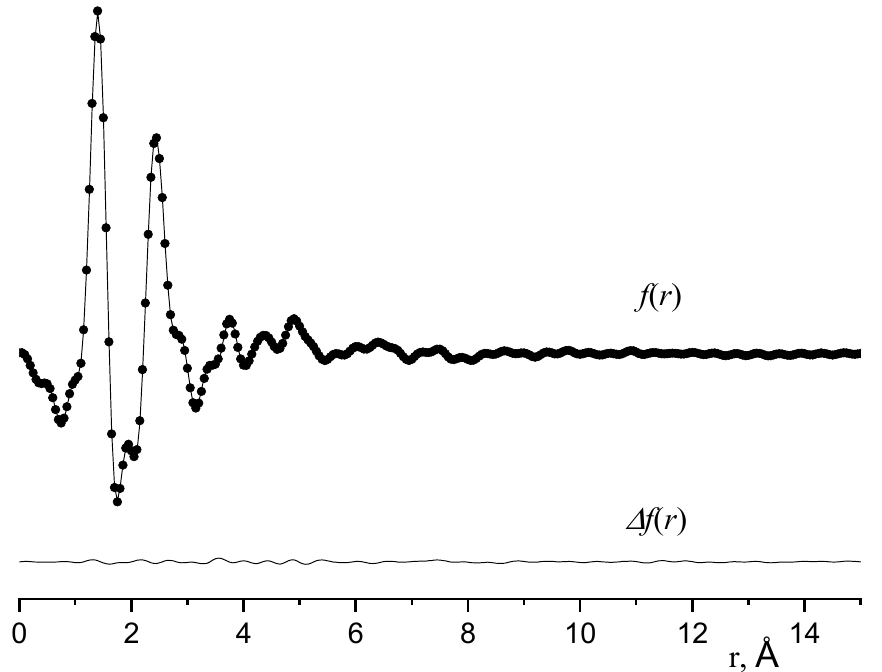
Figure 10. Experimental (dots) and theoretical (full line) radial distribution function f(r) for mole percent of 50/50 cis / trans vapor model and residual curve for 4-(4-tritylphenoxy)phthalonitrile.